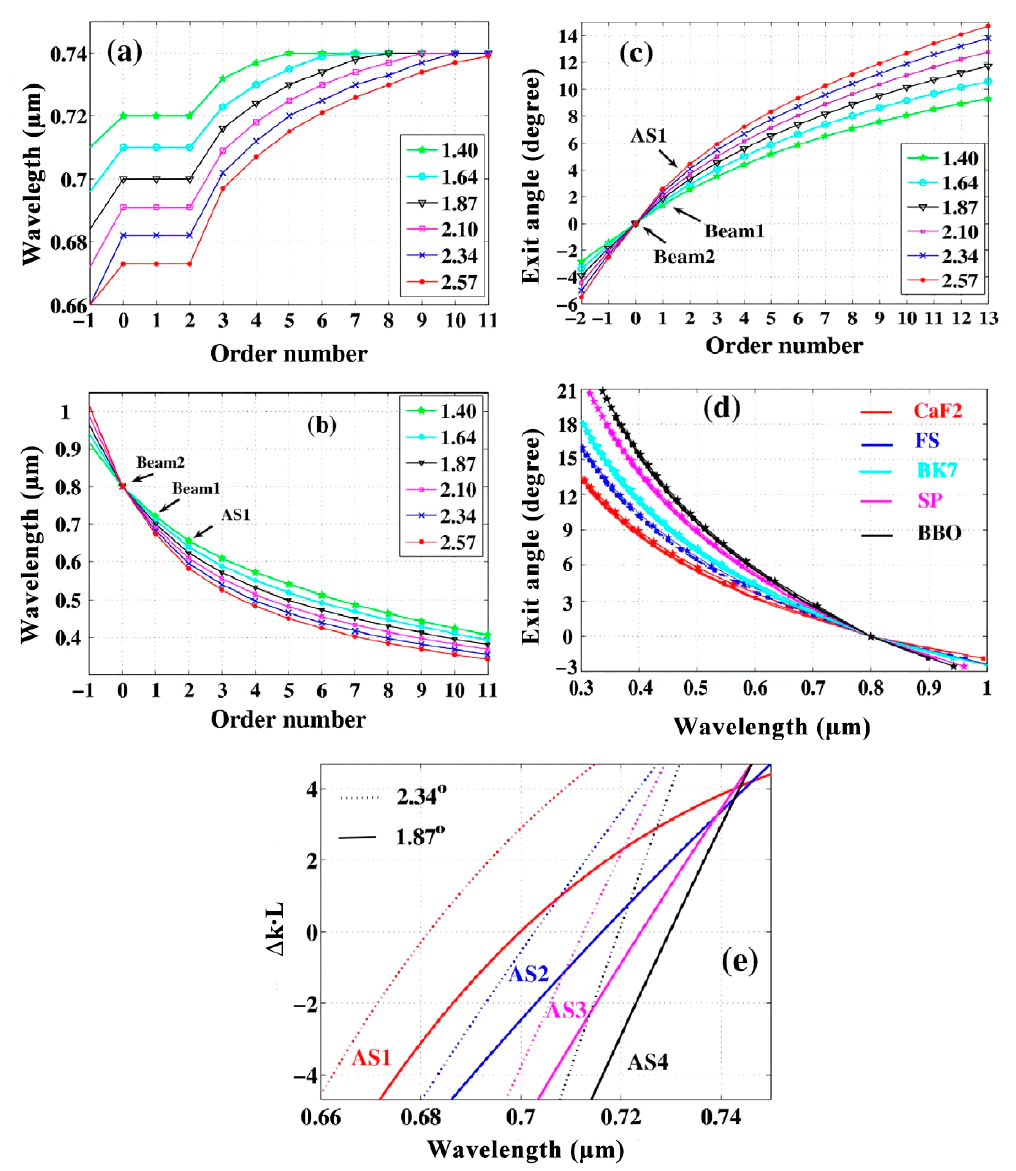
Figure 2. Calculated output parameters of generated sidebands. Dependence of ( a ) central wavelength of Beam 1 for minimum phase-mismatching; ( b ) the wavelength; and ( c ) the exit angles of generated sidebands on the order number at different crossing angles; ( d ) Dependence of exit angle of the generated sidebands on the center wavelength at three different cross-angles, 1.40°, 1.87°, and 2.57°, in different nonlinear media; ( e ) Phase mismatching of the sidebands from AS1 to AS4 at 1.87° and 2.34° in 1 mm fused silica